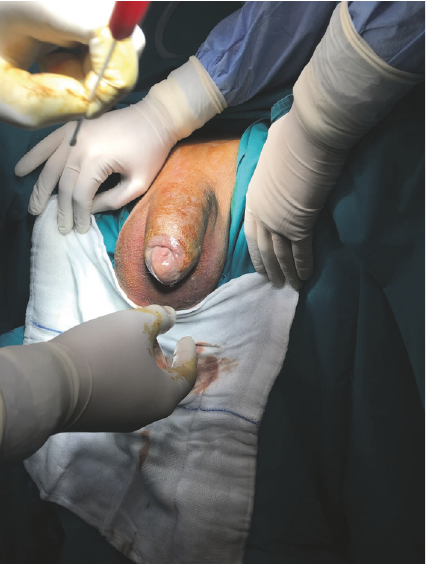
Figure 1: Swollen and dark-coloured penile shaft and purulent discharge from preputial ring.